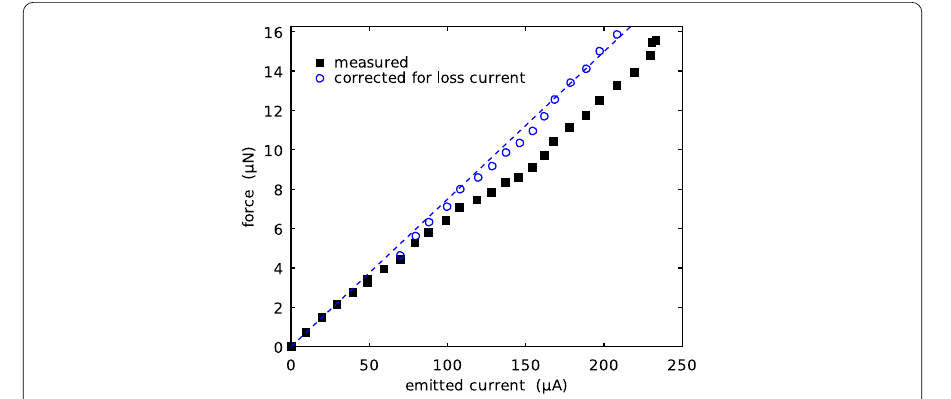
Figure 11 Indirect thrust measurement of a FEEP thruster with the force probe. Note the negative parallel offset at the higher currents due to ions missing the target. The correction for the loss current significantly reduces the